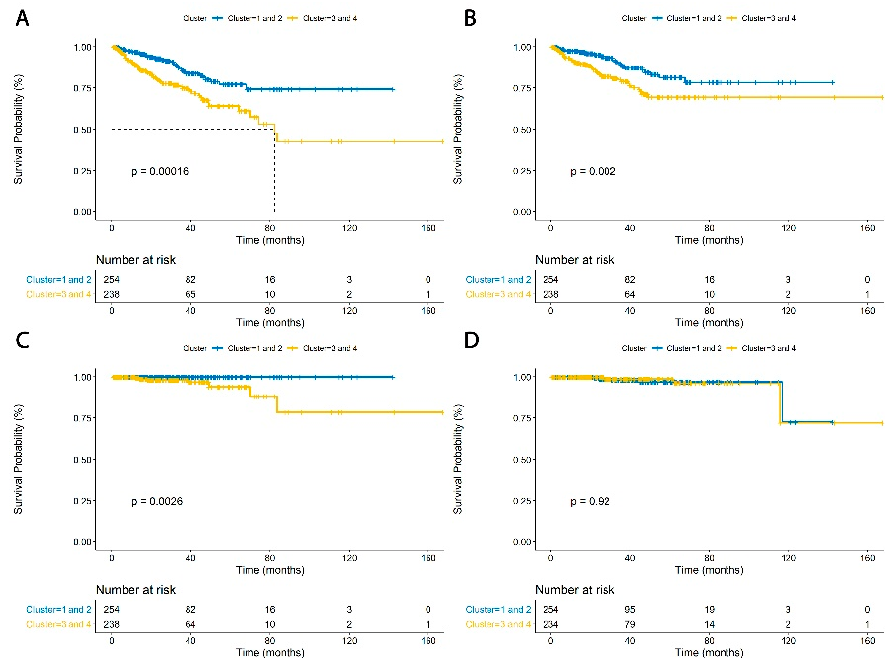
Figure 3. Panel ( A ) demonstrates the Kaplan–Meier curve for progression-free survival for grouped clusters 1 and 2 versus grouped clusters 3 and 4 (HR 2.243, 95% CI 1.458–3.450, p = 0.0002). ( B ) Biochemical recurrence (HR 2.128, 95% CI 1.302–3.479, p = 0.0026). ( C ) Distant metastasis (all events occurred in clusters 3 and 4, p < 0.0001). ( D ) Overall survival (HR 0.9319, 95% CI 0.2488–3.49, p = 0.917).